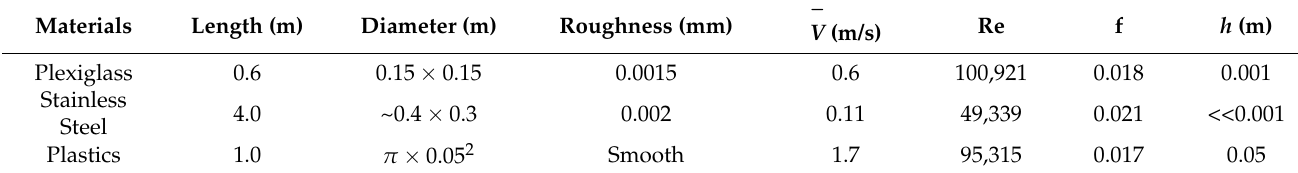
Table 1. List of friction and major head loss of pipes and channels involved in the designs. Materials Length (m)